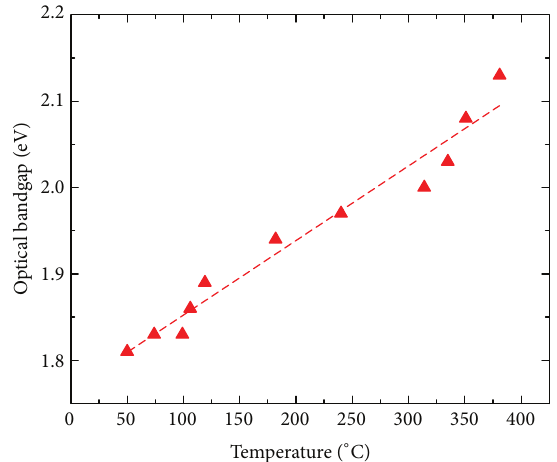
Figure 10: Optical bandgap as a function of process temperature. The line is a guide for the eye. A linear dependence of bandgap on displays temperature can be H